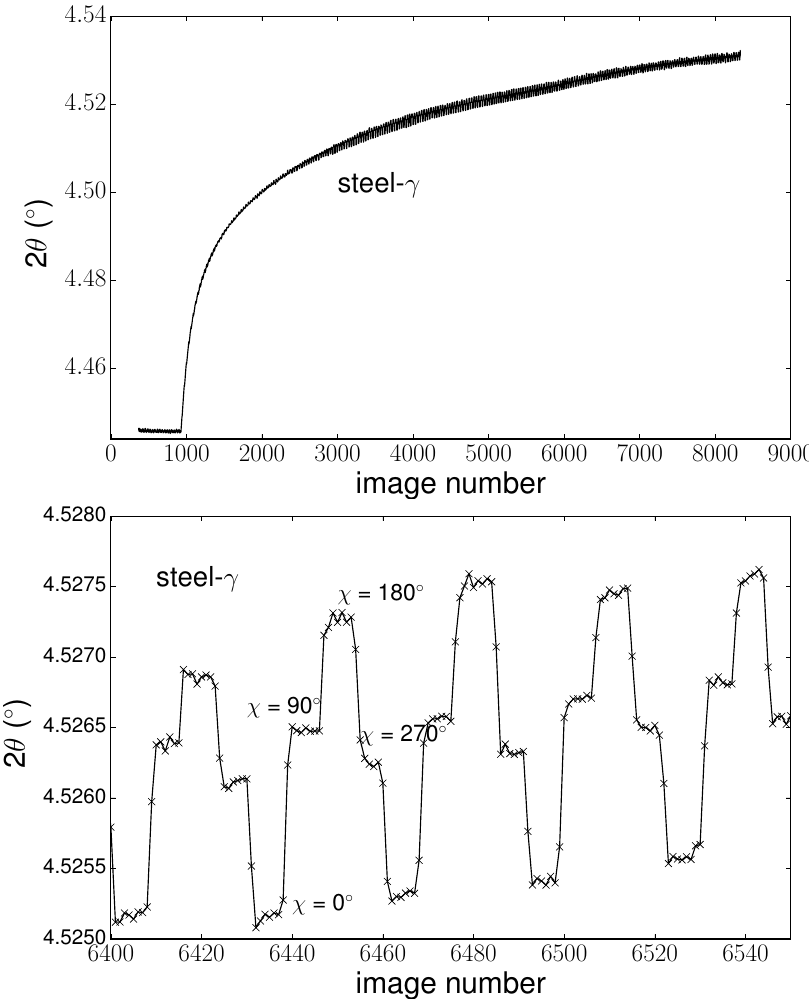
Figure 5. Evolution of peak position ( γ (200)) over image number, and a zoomed view of image numbers